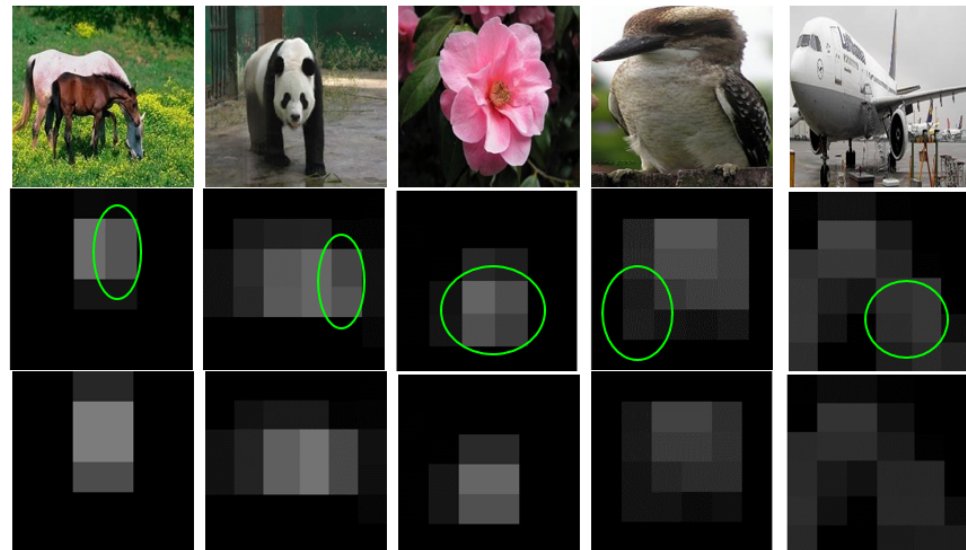
Figure 8. Visualization of learned feature maps from DSF-Pooling and max pooling. The second row and third row are from DSF-Pooling and max pooling layers, respectively. The DSF-Pooling layer reveals more semantics from image